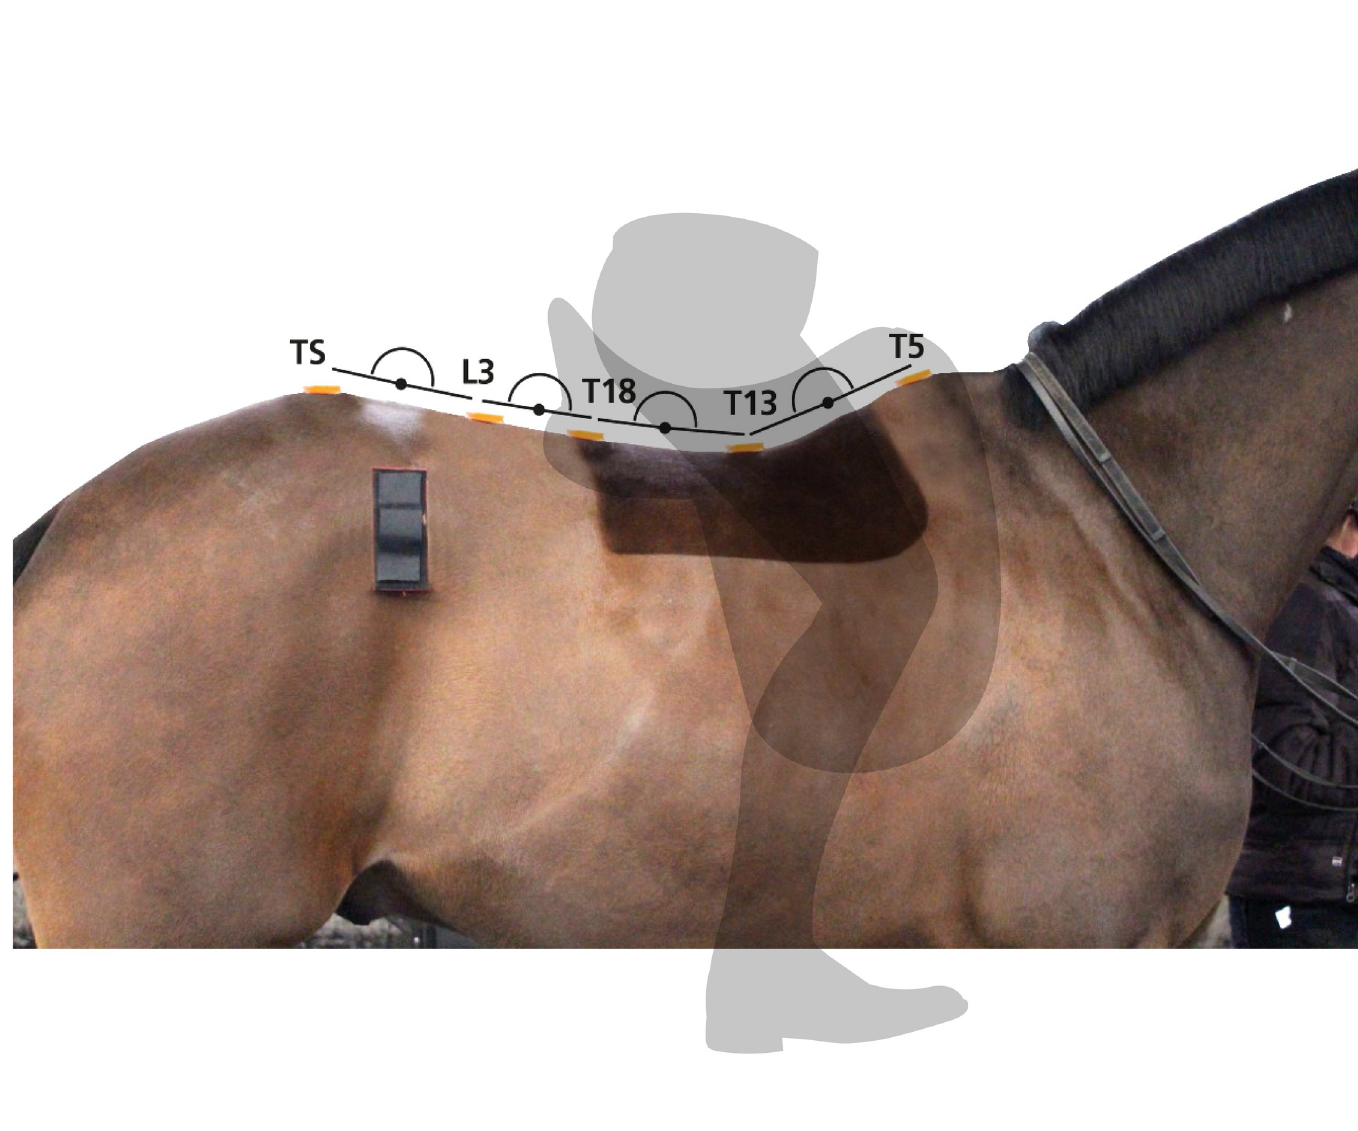
Fig 1. IMU sensor locations in the thoracolumbosacral region. Sensors were glued on to the skin at T5, T13, T18, L3 and TS. Sensors were positioned on the midline with sensors T5, T13 and T18 being positioned beneath the saddle. Sensor pouches were used for the left and right tuber coxae. Differential pitch, heading and roll rotations were calculated between adjacent sensors T5-T13, T13-T18, T18-L3 and L3-TS. Movement symmetry values were calculated from displacement minima and maxima for each sensor.